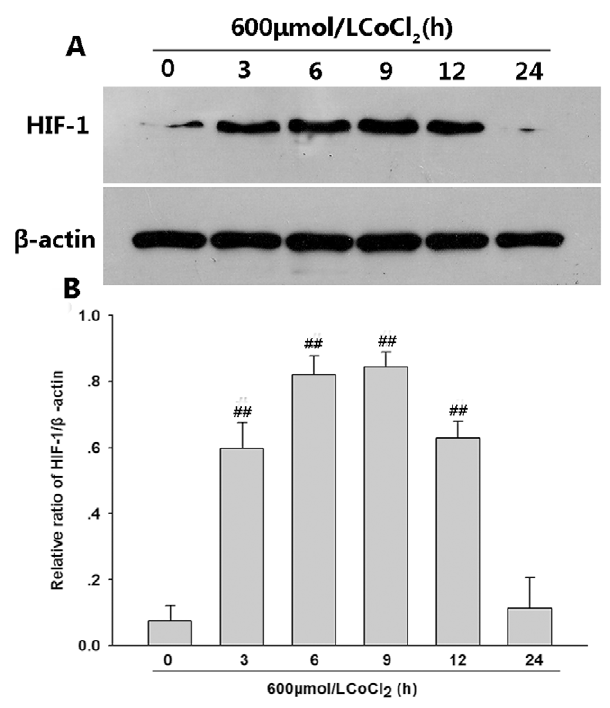
Figure 2. Effects of CoCl 2 on the expression of CBS in PC12 cells. PC12 cells were treated with 600 m mol/L CoCl 2 for different times. (A) The expression levels of CBS in PC12 cells were examined by western blot and b -actin was used as internal control. (B) Denstiometric analysis for the data from (A) with the Image J 1.41o software. Values are the mean 6 SE (n=3). ## P , 0.01 compared with control group (0h).